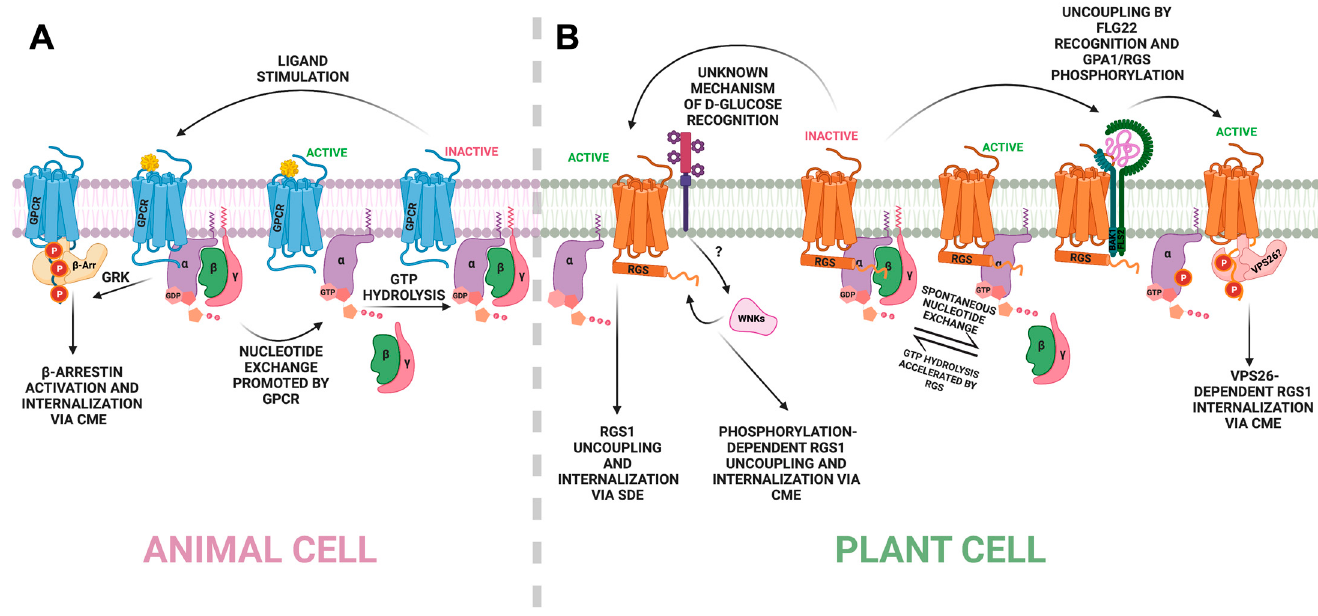
Figure 1. Conserved and non-conserved G-protein activation mechanisms in plants and animals. ( A ) An animal cell recognizes an extracellular signal via GPCR that promotes nucleotide exchange at the alpha subunit. GTP-bound G α releases G βγ for downstream signaling. Inactivation occurs under GTP hydrolysis and phosphorylation-induced GPCR internalization. ( B ) Nucleotide exchange is spontaneous in plant cells with no characterized GPCR. Negative regulation via GTPase acceleration activity is promoted by 7TM-RGS proteins. D-glucose activates endocytosis via two different mechanisms: RGS1 is phosphorylated by the WNKs and internalized in a VPS26-independent module via clathrin-mediated endocytosis (CME), or RGS1 is internalized in a phosphorylation-independent mechanism via sterol-dependent endocytosis (SDE). Flg22 is recognized by the BAK1/FLS2 complex, and multiple phosphorylation occurs at GPA1 and at the C-terminus of RGS1. The phosphorylated core is uncoupled, and downstream signaling is activated. Flg22-induced RGS1 internalization occurs via CME in a β -arrestin-like mechanism mediated by the VPS26 proteins. Created with BioRender.com (Publication license OL240ET01G. Accessed on 7 June 2022).